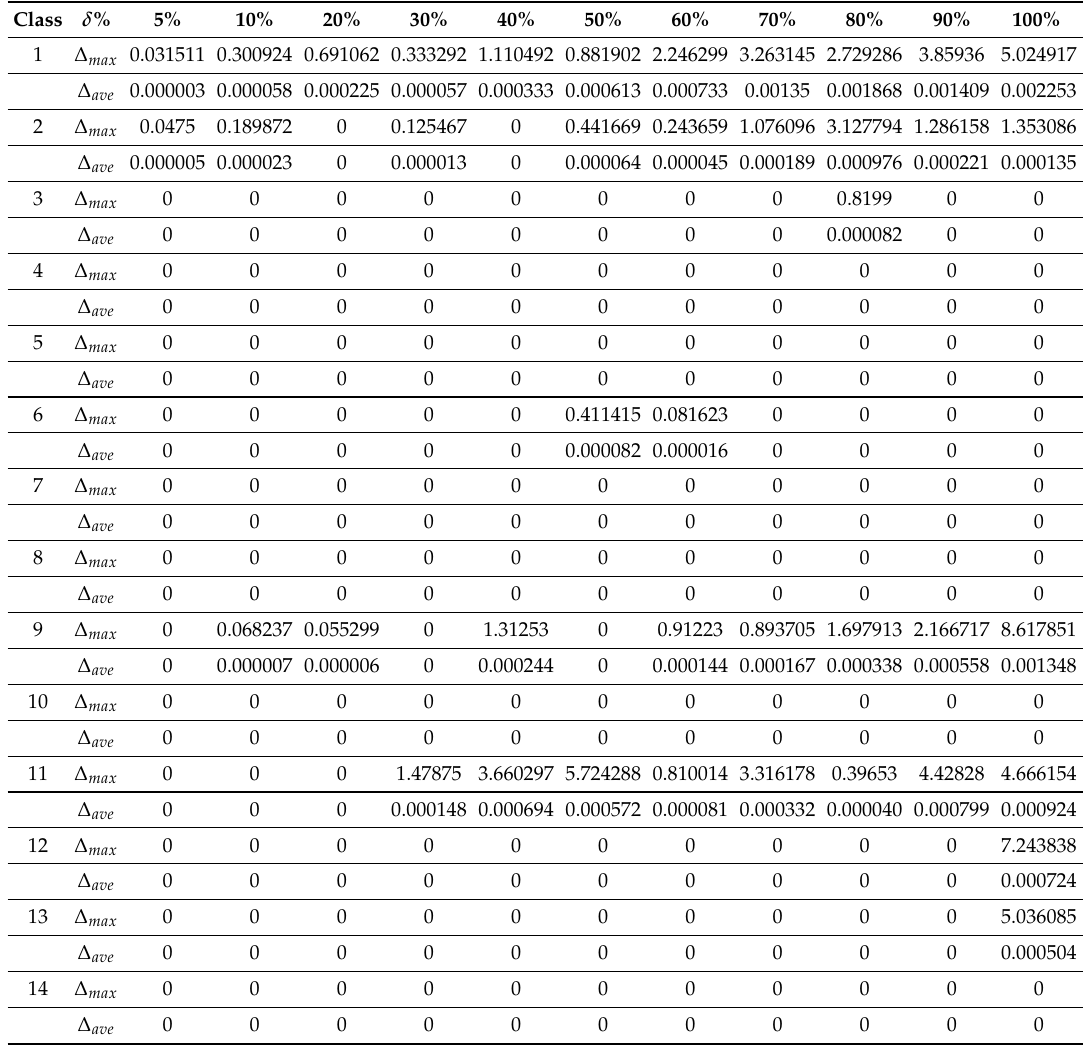
Table 4. Maximal errors ∆ max and average errors ∆ ave for all tested instances with factual processing times randomly generated based on a uniform